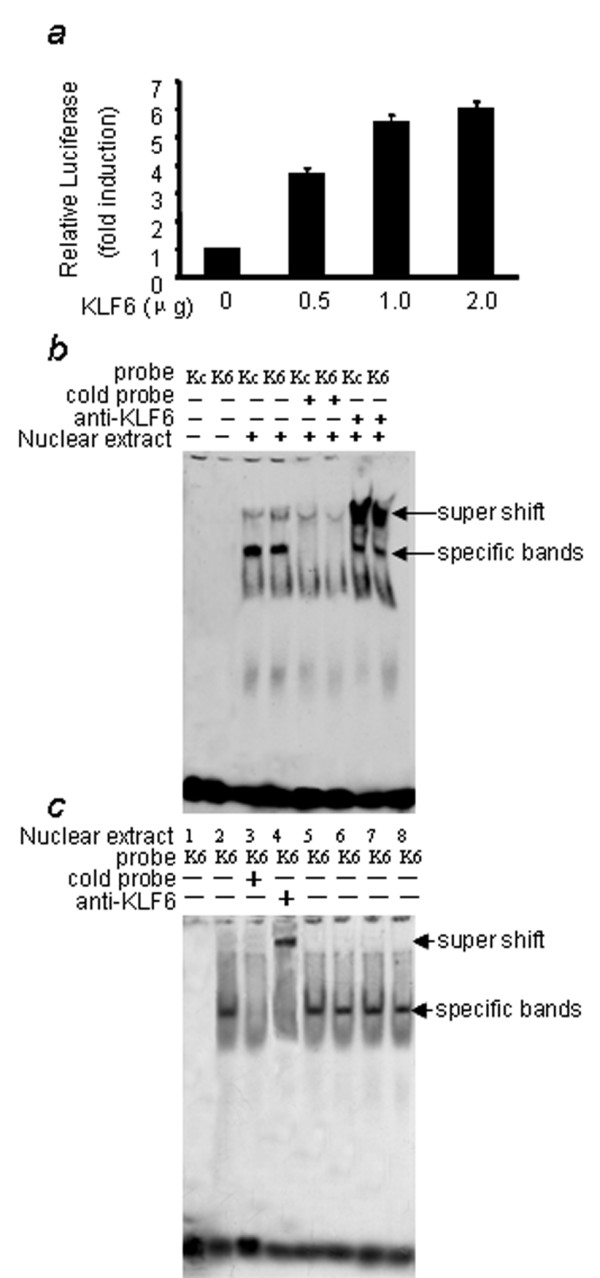
KLF6 can transactivate and binds to the promoter of TFPI-2. (A) The p-144 promoter-luciferase activity induced by cotransfection with various amount of KLF6 expression plasmids in MDA-MB-435 cells. The KLF6 cDNA was a generous gift of Scott Friedman and was cloned into PCDNA 3.0 expression vector. (B) Both the predicted KLF6 binding sequence (K6) and the authentic KLF6 binding (Kc) [46] can form specific bands with nuclear extract (NE) from MCF-7 cell lines. And the specific bands were supershifted by the antibody of KLF6. (C) No difference of K6 binding activity was found between MCF-7 and MDA-MB-435 cell lines. Lane 1 to 6: NE from MCF-7; lane 7, 8: NE from MDA-MB-435. Lane 5, 7: 2.5 μg NE; lane 6, 8: 5 μg NE.